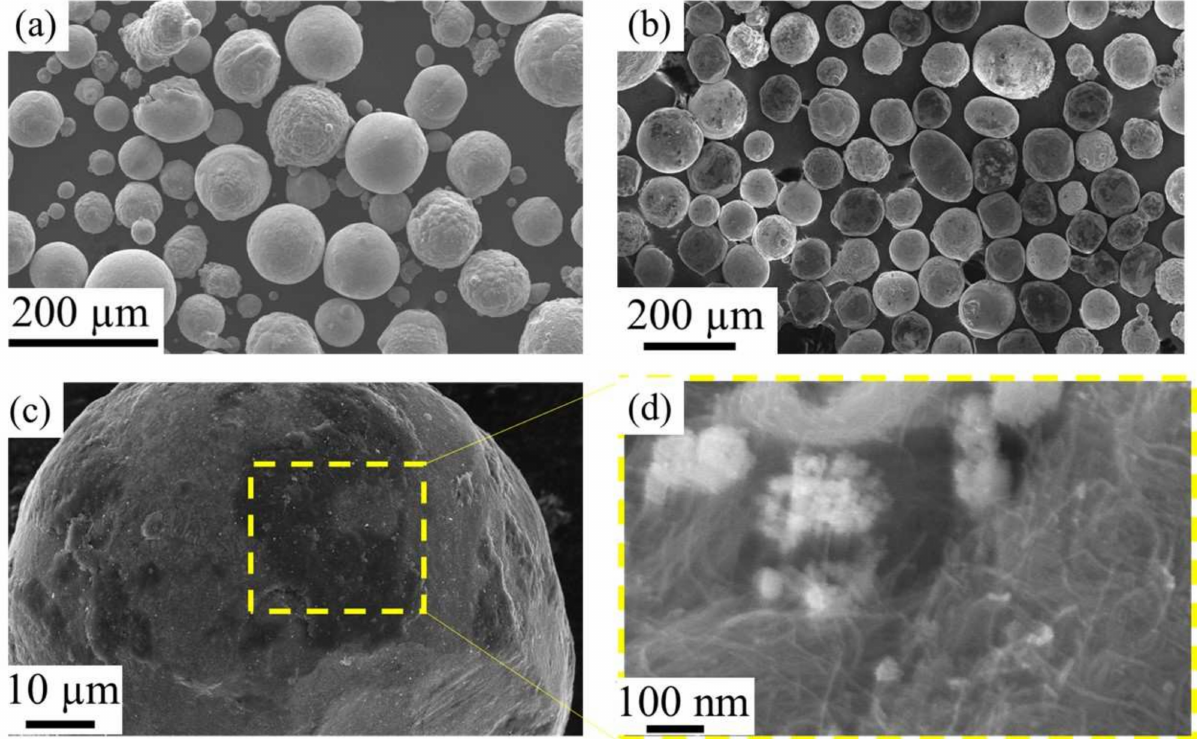
Figure 1. Scanning electron microscopy of ( a ) Cu powder, ( b ) Cu-CNTs powders, ( c ) high magnifica- tion of one Cu particle after mixing with CNTs, and ( d ) high magnification of dark parts (selected dashed square) showing CNTs on surface of